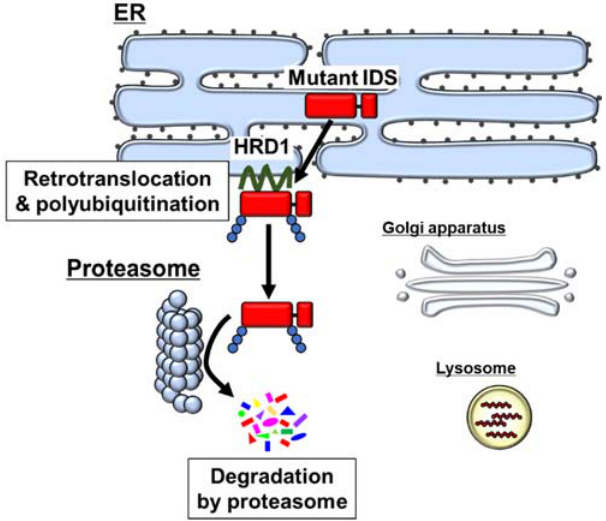
Figure 2. Degradation of IDS in the ERAD pathway. Mutant IDS accumulates in the ER, followed by retrotranslocation to the cytoplasm and polyubiquitination. The polyubiquitinated mutants are degraded by proteasomes.